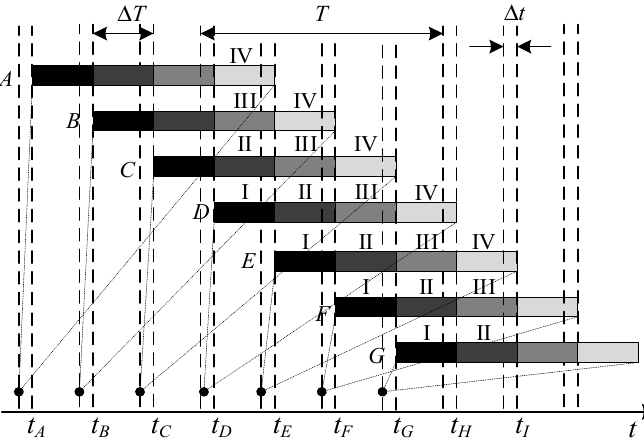
Figure 4. Overview of the intra-day rolling dispatch.